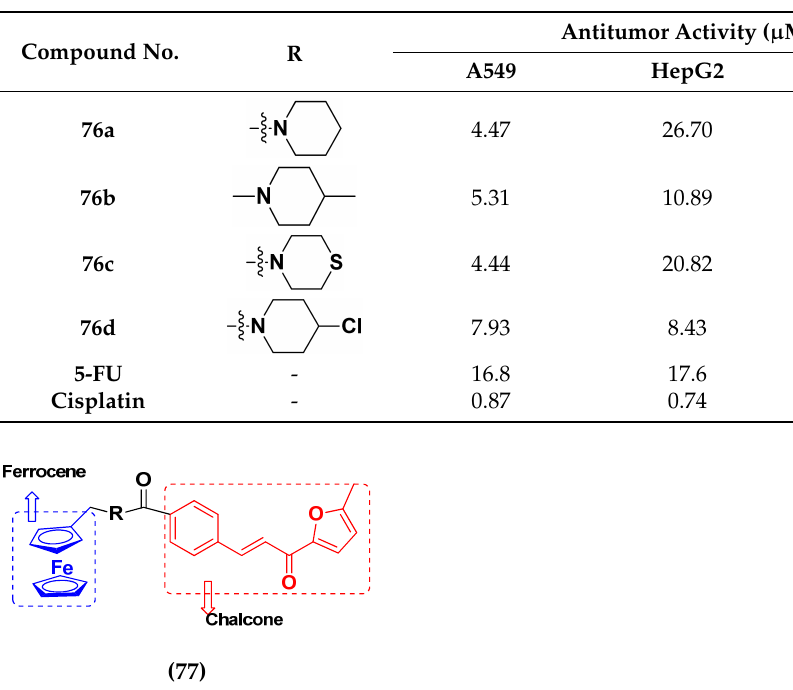
Figure 74. Structure of ferrocenyl-chalcone amide derivative ( 77 ). Table 63. In vitro cytotoxic activities of ferrocenyl-chalcone amide hybrid compounds 77 ( a – d ). Compound